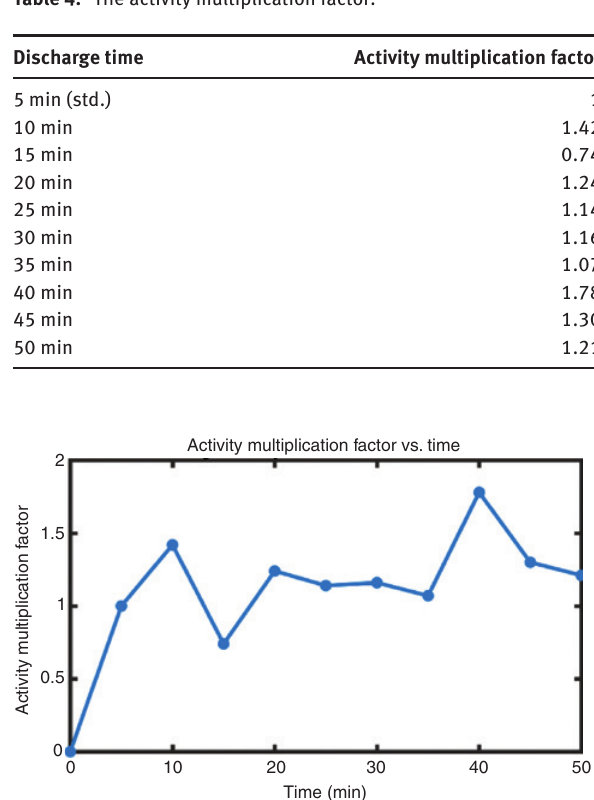
Table 3: The testing liquid dilution rate.